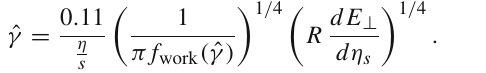
theory studied here, the